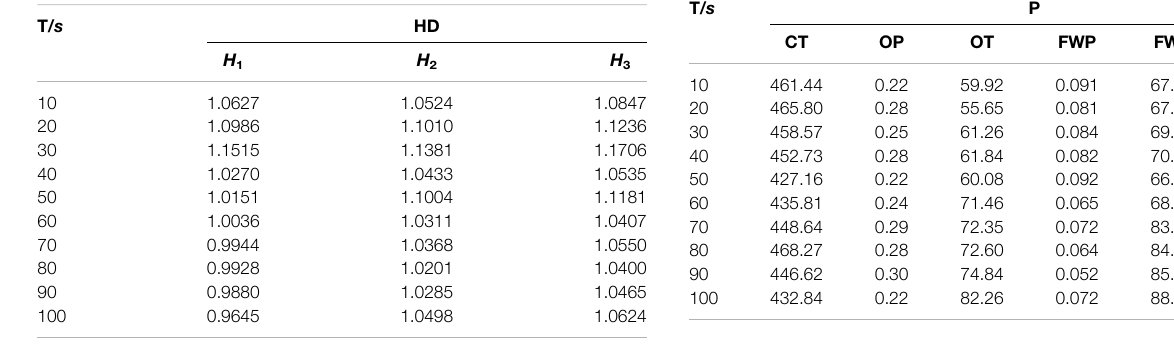
TABLE 4 | Healthy degree of engine equipment from normal operation to fault 1.